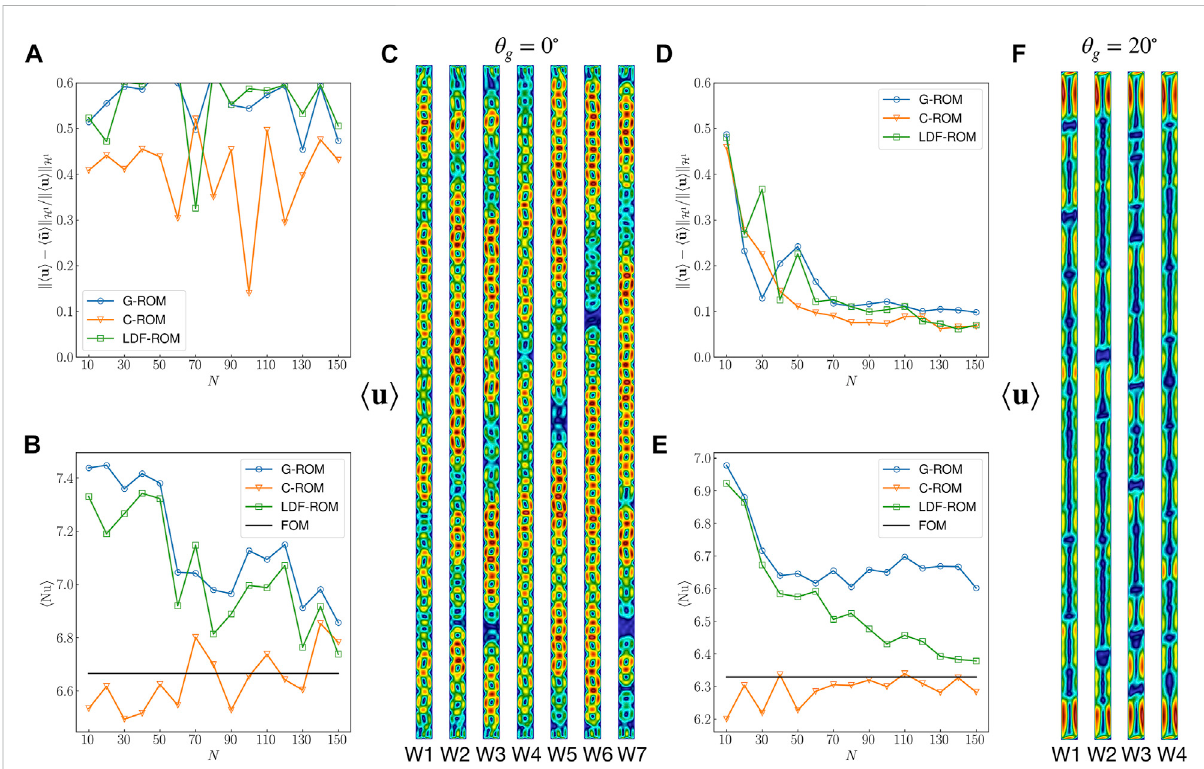
FIGURE 10 ROM performance comparison between problem having signi fi cant ( θ g = 0 ° ) and less signi fi cant ( θ g = 20 ° ) spatio-temporal chaotic fl ow at Pr = 7.2 and Ra = 3 × 10 5 . (A – C) Behavior of the relative H 1 error and mean Nu as a functions of N and magnitude of the mean velocity at multiple time windows W1, ... , W7 at θ g = 0 ° . (D – F) performance for the same quantities at θ g = 20 °